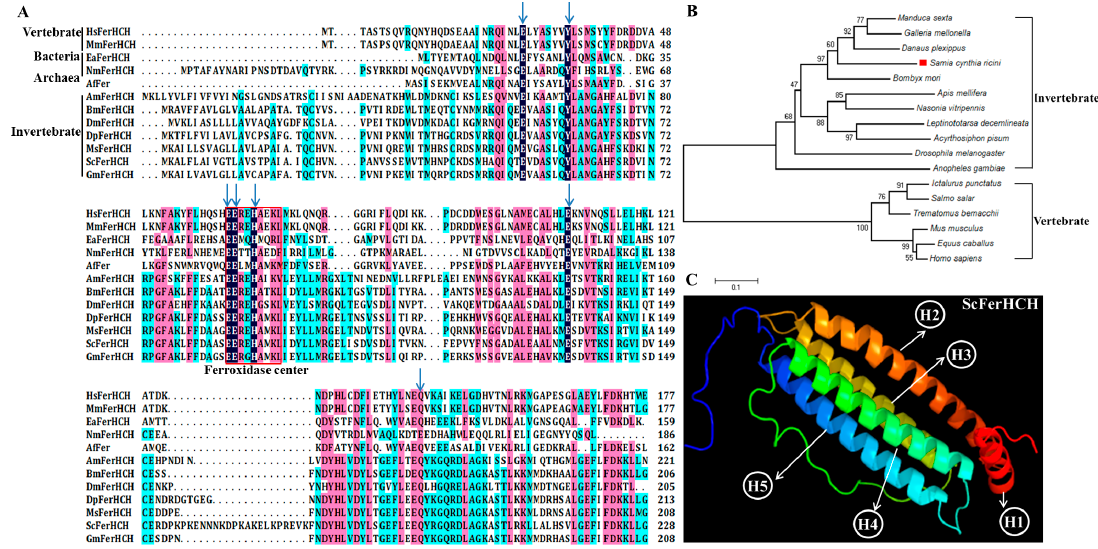
Figure 2. ( A ) Sequence alignment of the ScFerHCH protein with its homologs from different species. The conserved amino acid residues are highlighted in black and similar amino acid residues are labelled in pink. The conserved amino acid residues of the ferroxidase center are marked by the red box. The residues required for ferroxidase activity are indicated with blue arrows above the sequences; ( B ) Phylogenetic relationships of ferritin heavy chain subunit in different species using the neighbor-joining method with a bootstrap value of 1000; ( C ) Predicted tertiary structure of the ScFerHCH protein using the phyre2 online software. Red is the N-terminus, and blue is the C-terminus. The ScFerHCH protein contains four long α -helices (H2-H5) and one short α -helix (H1).